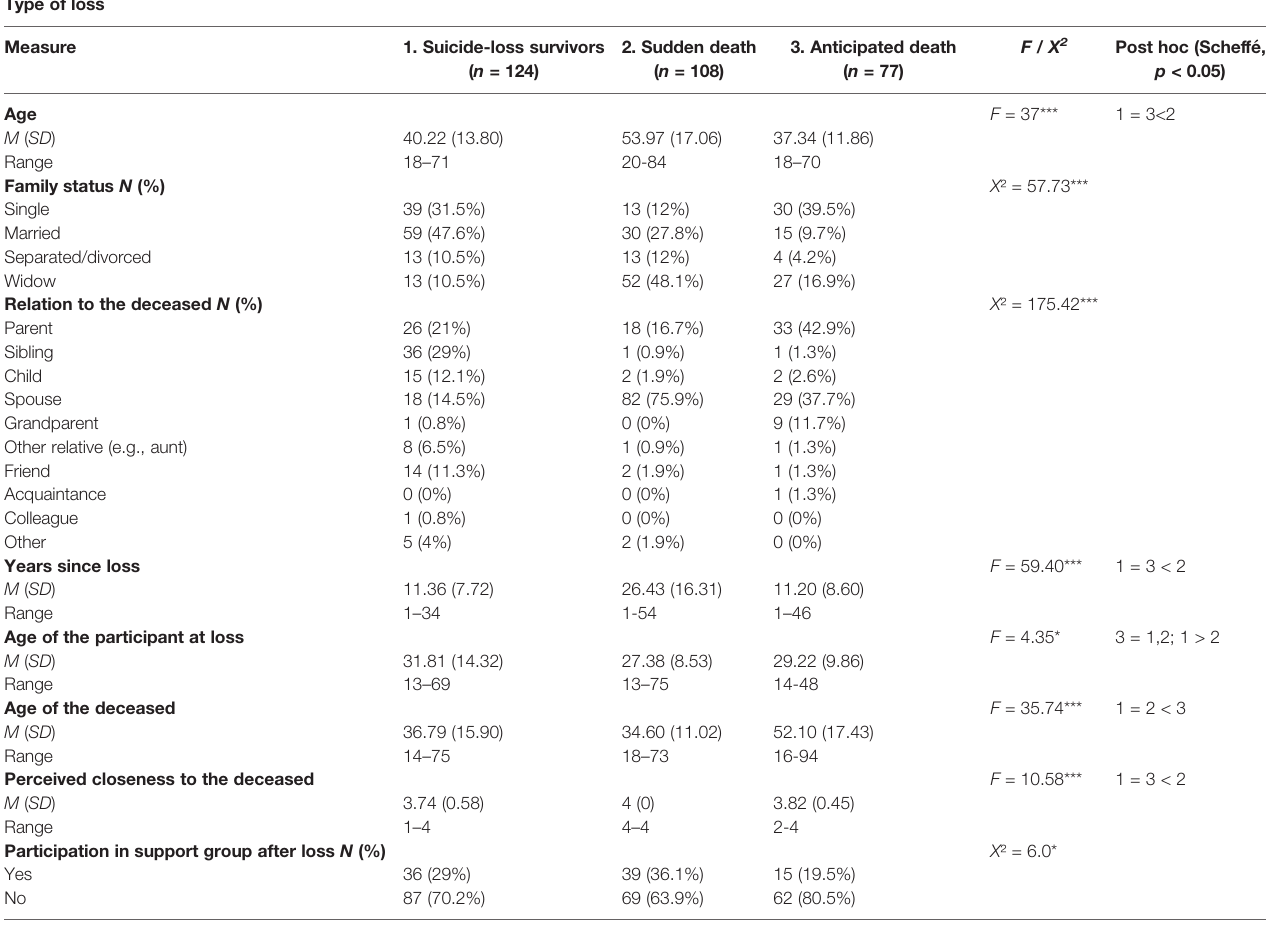
TABLE 1 | A Group differences in demographic and loss-related variables ( N =